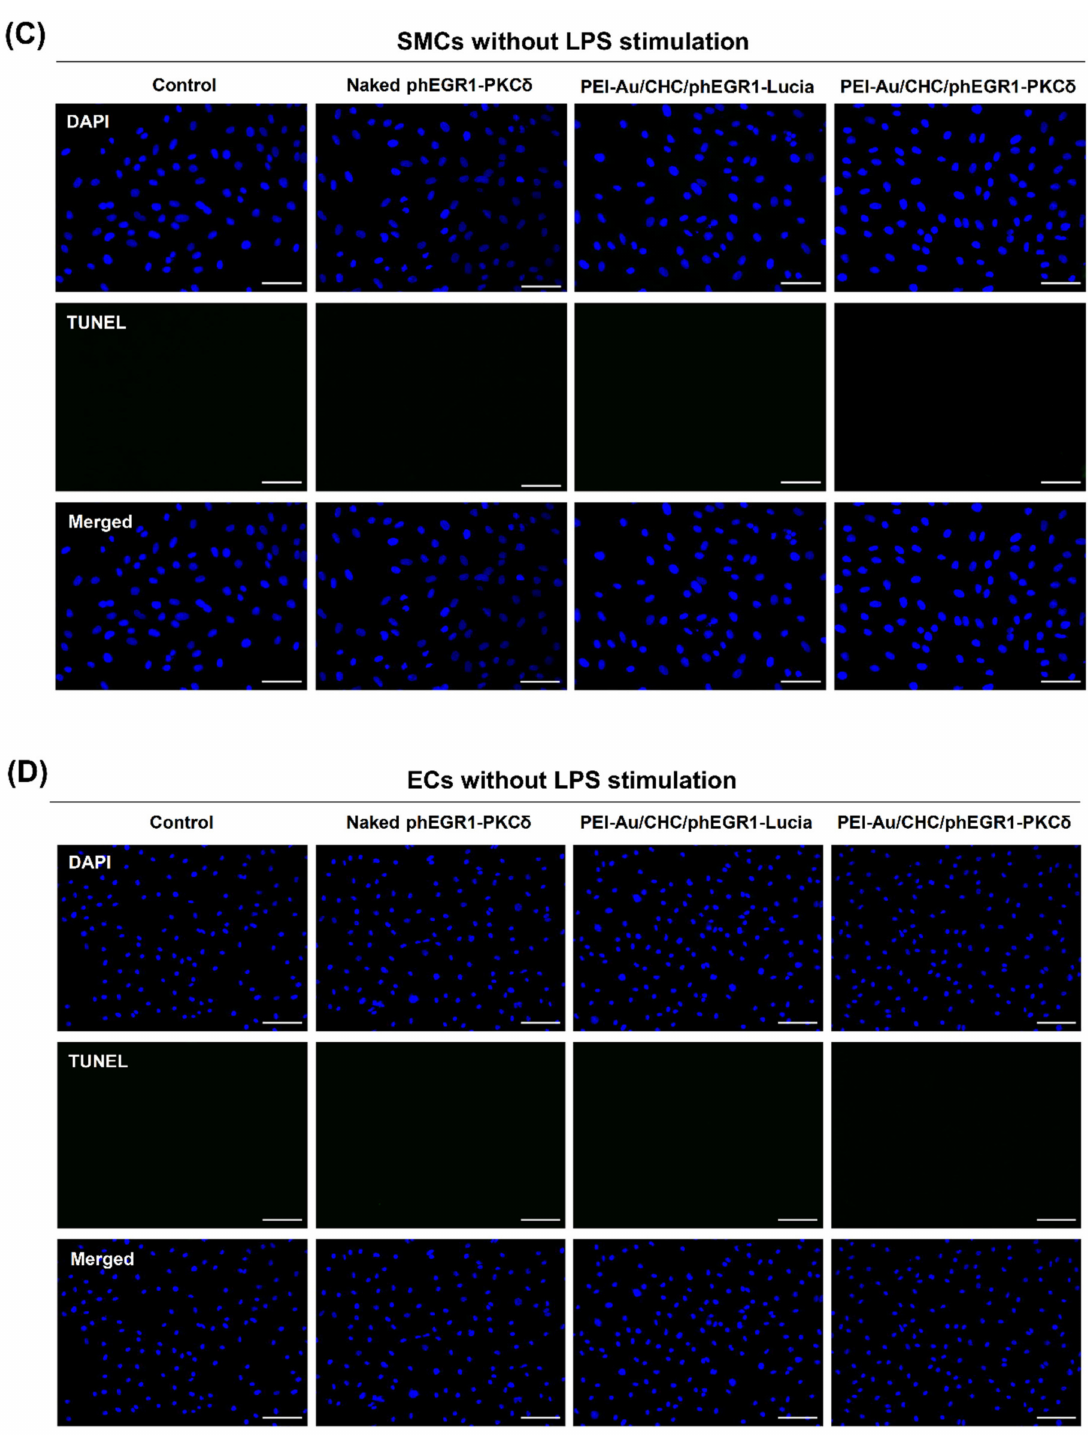
Figure 7. Terminal deoxynucleotidyl transferase dUTP nick end labeling (TUNEL) assay of ( A ) SMCs and ( B ) ECs treated with naked phEGR1-PKC δ , the PEI-Au / CHC / phEGR1-Lucia complex, and the PEI-Au / CHC / phEGR1-PKC δ complex under conditions with LPS stimulation. TUNEL assay of ( C ) SMCs and ( D ) ECs treated with naked phEGR1-PKC δ , the PEI-Au / CHC / phEGR1-Lucia complex, and the PEI-Au / CHC / phEGR1-PKC δ complex under conditions without LPS stimulation. All cells were stained with TUNEL (green) to label DNA fragmentation and DAPI (blue) to label cell nucleus. Scale bar, 100 µ